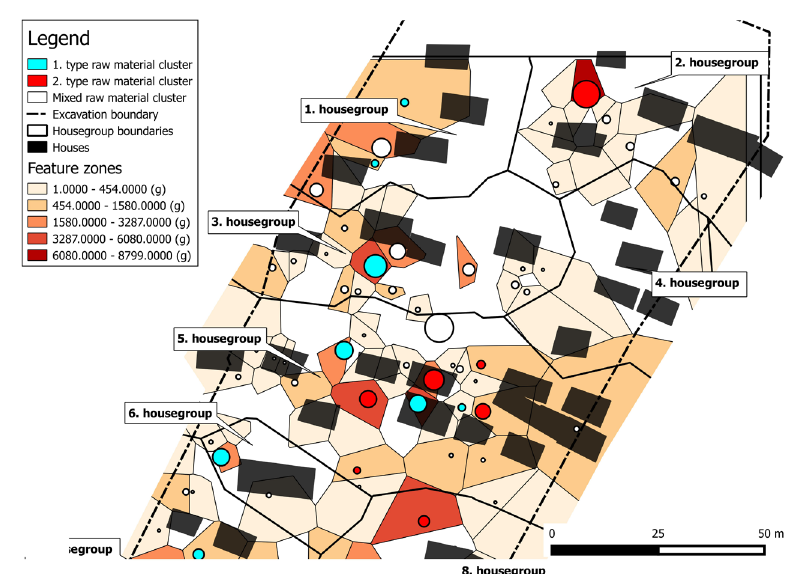
Figure 17: Houses, house groups, and activity zones in the northern section of the horizontal settlement.